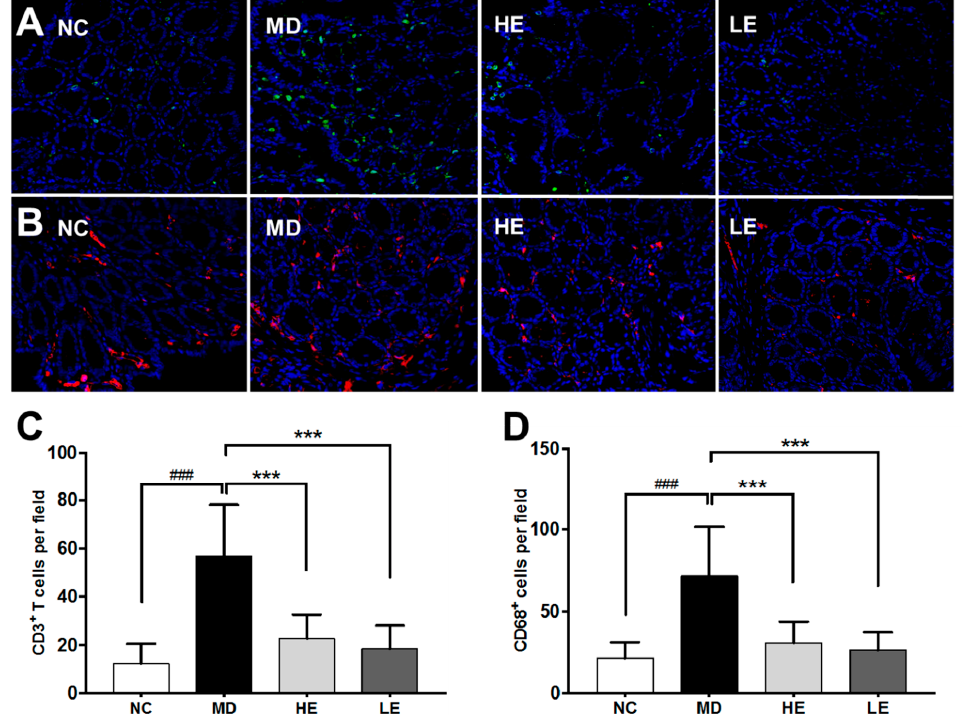
Figure 5. The effect of EGCG treatment on immune cell infiltration in colonic tissue in DSS-induced colitis. Representative immunofluorescence staining for CD3+ T cells ( A ) and CD68+ macrophages ( B ) in the NC, MD, HE, and LE groups of mice (from left to right, 40x) are displayed. Ten randomly chosen fields (20X) per section were examined for fluorescent cells in each section and average cell numbers per field are shown. ( C , D ) show the quantitation of the same data; DSS-induced colitic mice exhibited significantly increased infiltration of T cells and macrophages in the colonic tissue. Both high-dose and low-dose EGCG treatment were able to decrease the number of infiltrating T cells ( C ) and macrophages ( D ) significantly when compared to the non-treated MD group. NC: Normal control group, MD: Colitis model group, HE: High-dose EGCG group, LE: Low-dose EGCG group. Data are presented as mean ± standard deviation. *** p < 0.001 vs. MD; ### p < 0.001 vs. NC.